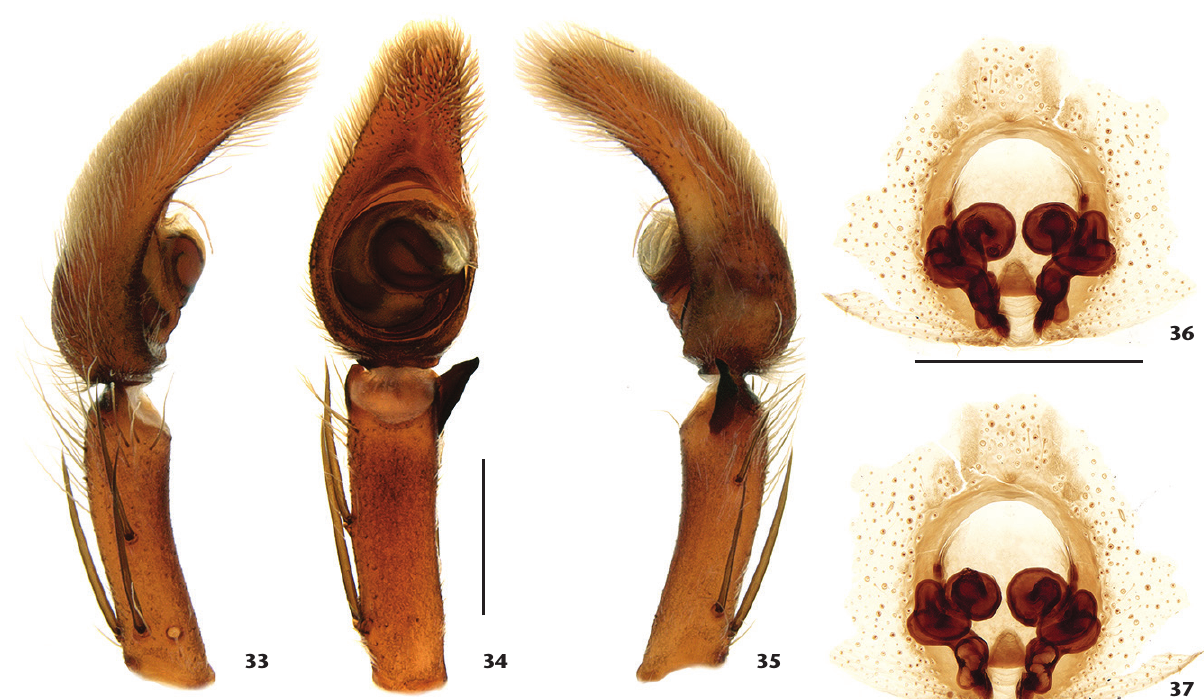
Description. Male (IBSP 54319). Prosoma pale yellow, slightly darker at eye area and pale orange along lateral margins of cephalic region and thoracic striae, with fine lines extending posteriorly from behind PME and PLE; fovea pale brown; eye borders black. Chelicerae pale orange. Legs and palps pale oran- ge with tarsi and metatarsi darker. Labium and endites cream colored, distally translucent white. Sternum cream colored with margins slightly more sclerotized and darker. Opisthosoma cream colored; dorsally with brown pattern of spots laterally and median irregular marks down posterior half (Fig. 3). Total